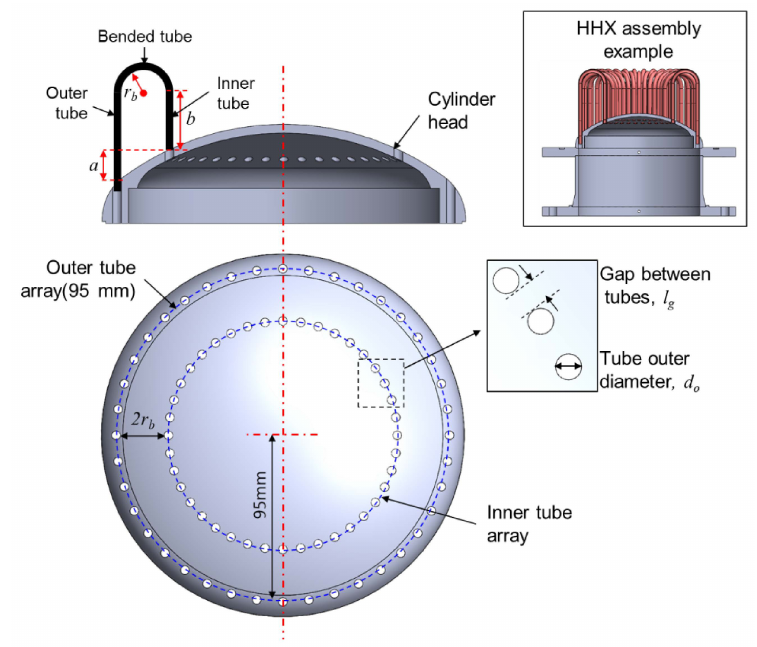
Figure 2. Shape structure of the cylinder head and the HHX tube.